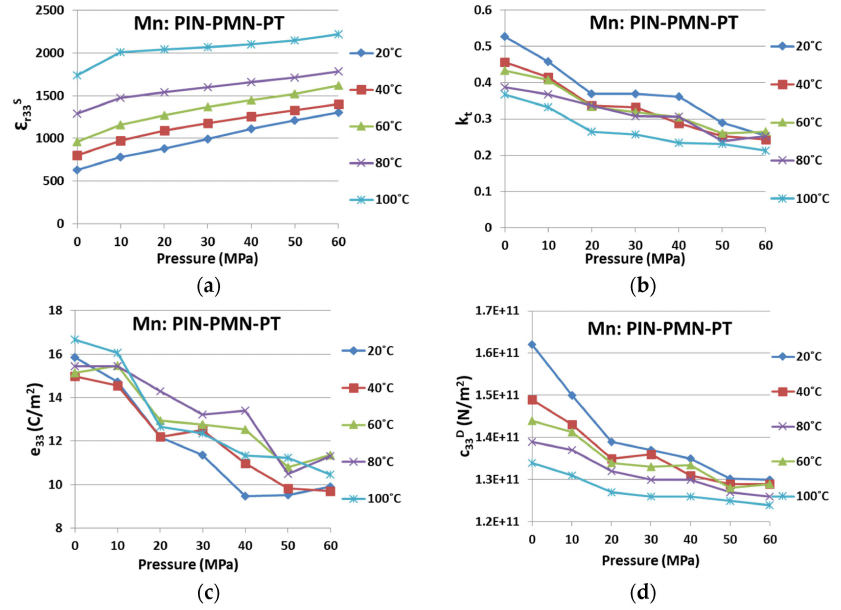
Figure 7. Property variation caused by environmental temperature and uniaxial pressure for Mn:PIN-PMN-PT on ( a ) ε r 33 S ; ( b ) k t ; ( c ) e 33 ; and ( d ) c 33 D